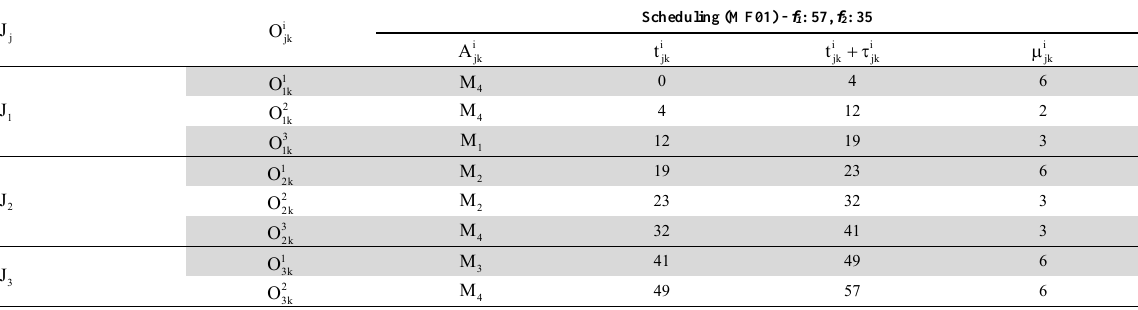
Scheduling of MF01 (MOHEA) (f1: 57, f2: 35) J i j